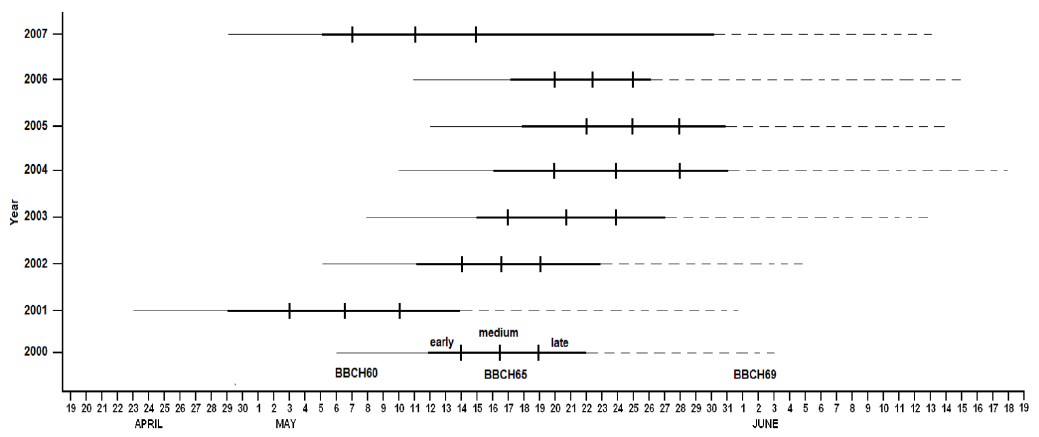
Figure 3. Phenogram illustration of flowering timing and duration over the eight years, with the indication of the limits calculated for early, medium, and late varieties.